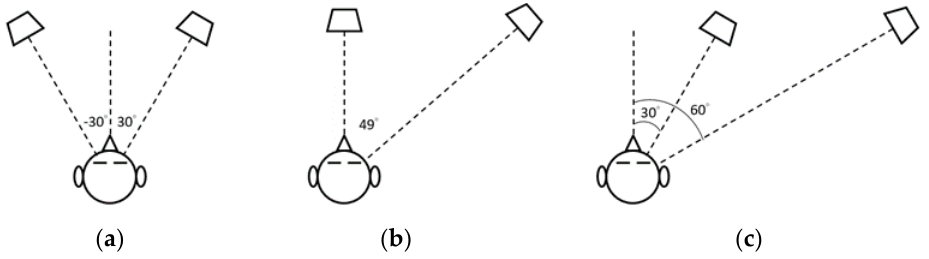
Figure 11. Loudspeakers track the head of the listener: ( a ) ideal situation and modified situation when the listener moves to the ( b ) immediate left and ( c ) left.